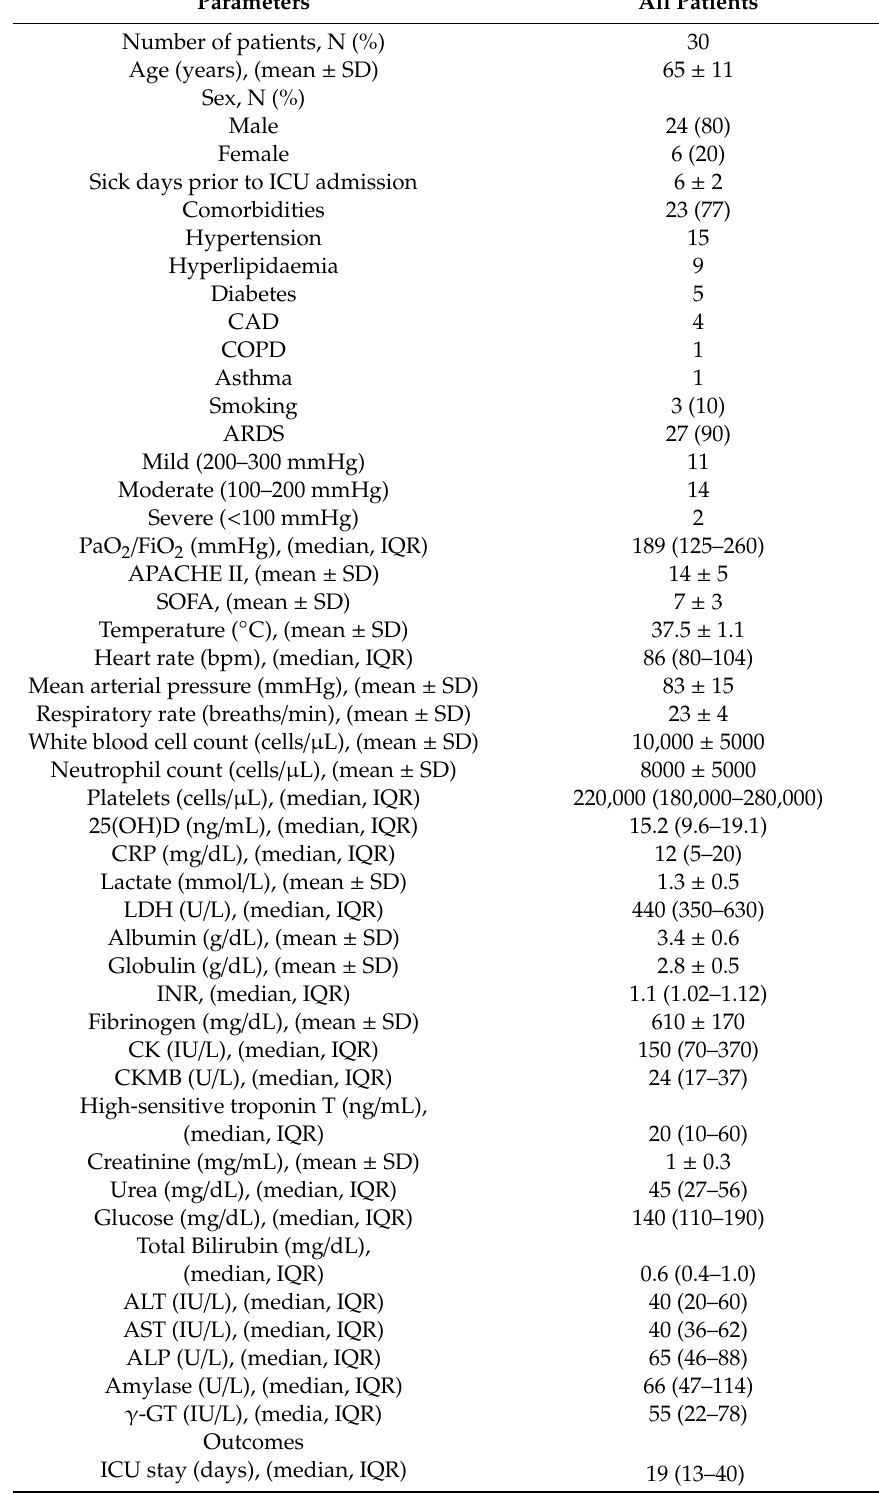
Table 1. Demographic, clinical characteristics and important outcomes of